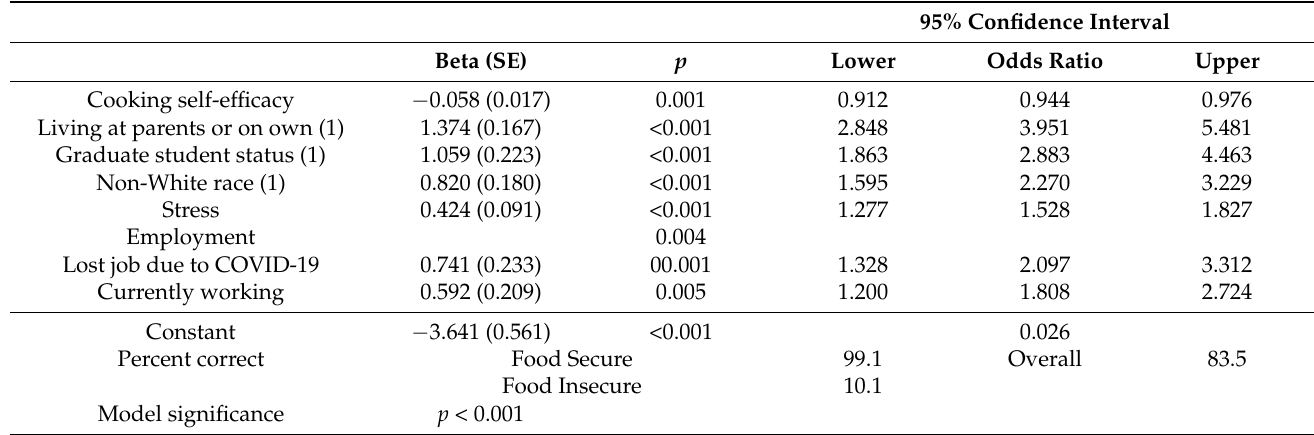
Table 5. Logistic regression model of predictors of food insecurity among Midwestern university students post-COVID closure of campus in March 2020 ( n =